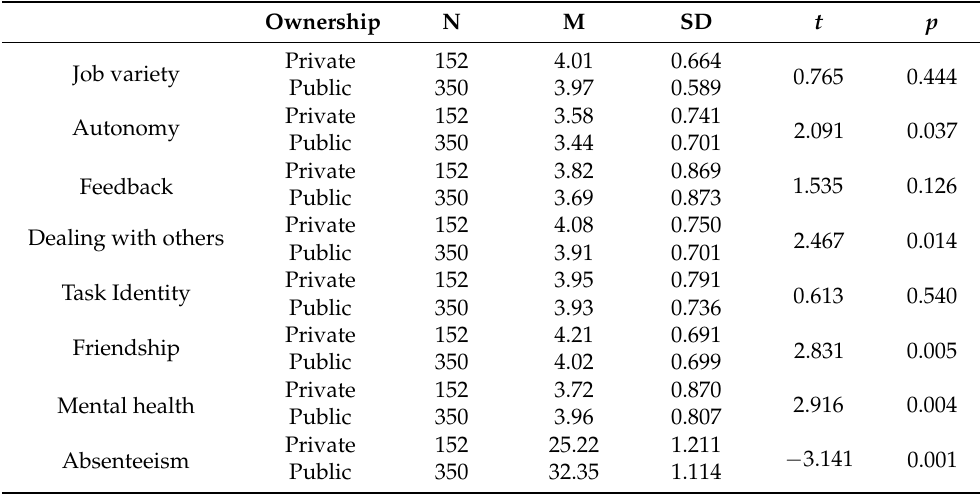
Table 6. t -test on independent samples—difference in ownership.